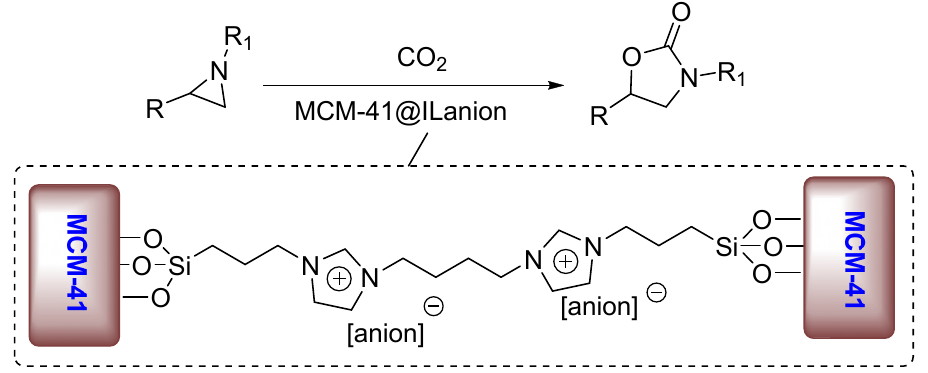
Scheme 1. Schematic diagram for catalytic synthesis of 2-oxazolidinones from CO 2 and